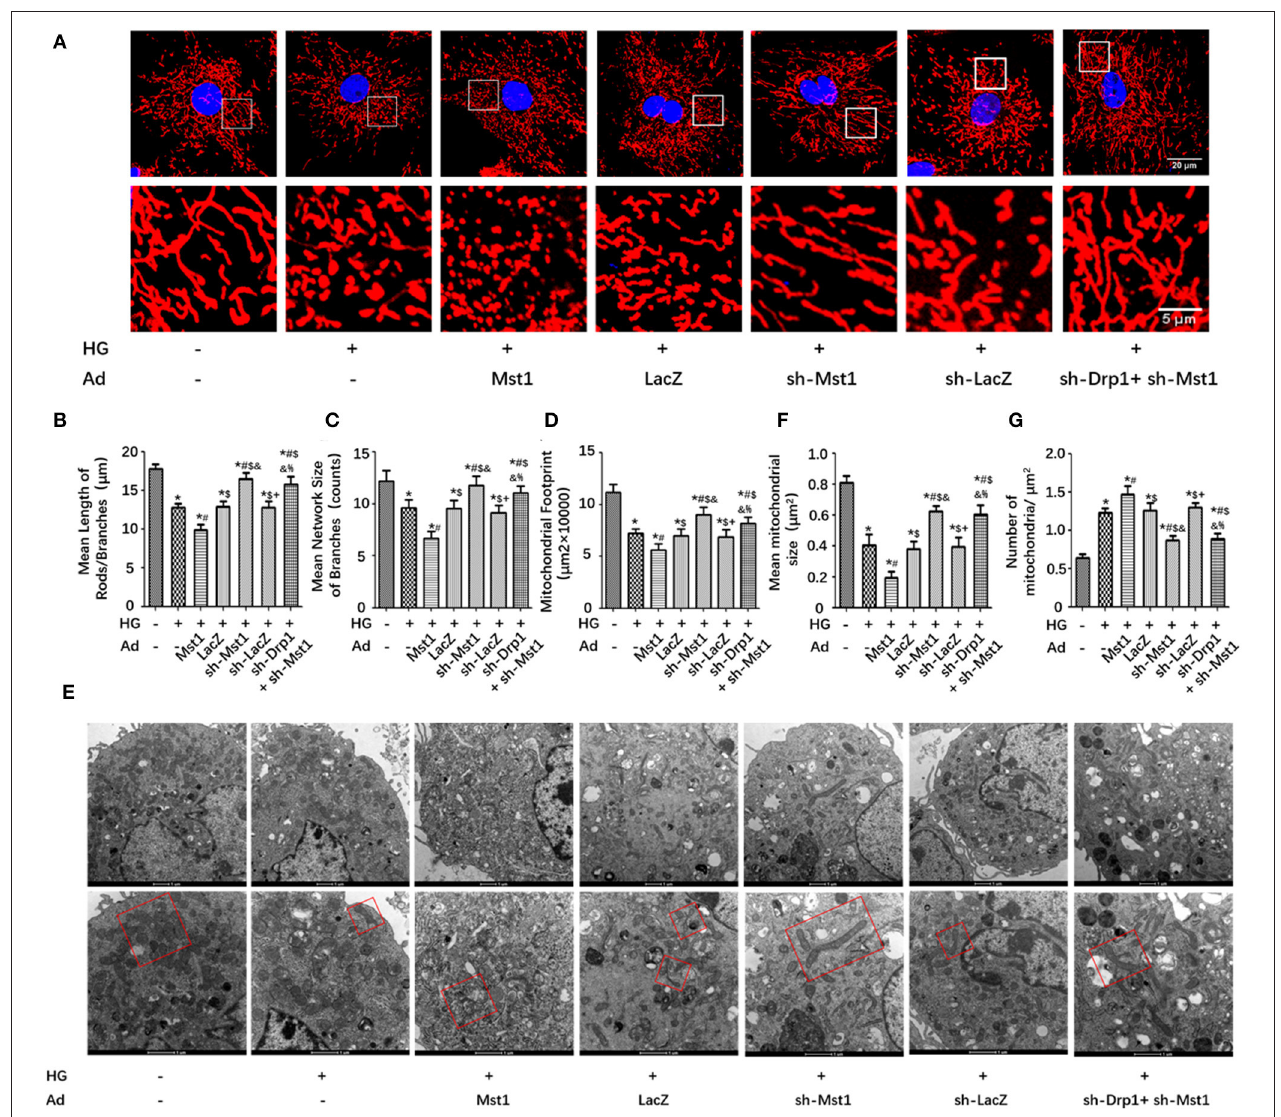
FIGURE 4 | Drp1 knockdown abolishes the effects of Mst1 on mitochondrial fission. (A) Representative images of mitochondria (MitoTracker Red) (Scale bars: upper panel 20 µ m, lower panel 5 µ m). (B) Quantitative analysis of the mean length of mitochondria rods/branches. (C) Quantitative analysis of the number of branches. (D) Quantitative analysis of the mitochondrial footprint. (E) Representative images of typical damaged and different sized mitochondria (Scale bars: upper panel 1 µ m, lower panel 500nm). (F) Quantitative analysis of the mean mitochondrial size. (G) Quantitative analysis of the number of mitochondria per µ m 2 . The columns and error bars represent the means and SEM. * P < 0.05 vs. Con; # P < 0.05 vs. HG; $ P < 0.05 vs. HG + Ad-Mst1; and P < 0.05 vs. HG + Ad-LacZ; + P < 0.05 vs. HG + Ad-sh- Mst1; and % P < 0.05 vs. HG + Ad-sh- LacZ.